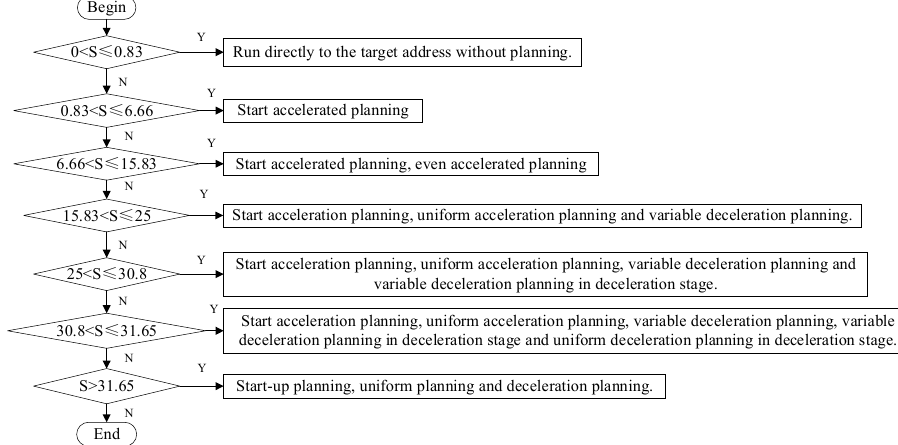
Figure 22. Operation flow of the end-effector joint motor.